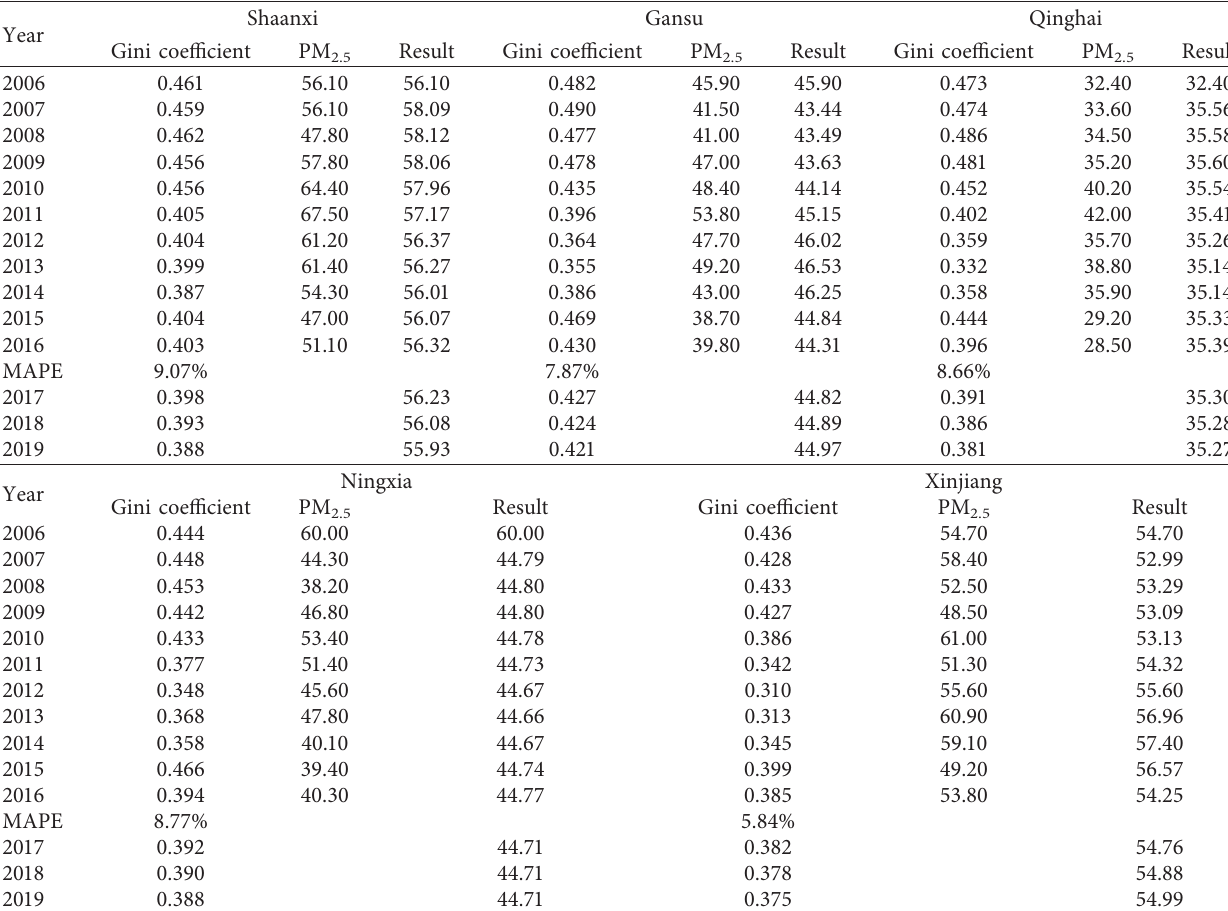
Table 5: Fitting results of the PM 2.5 concentrations in Northwest